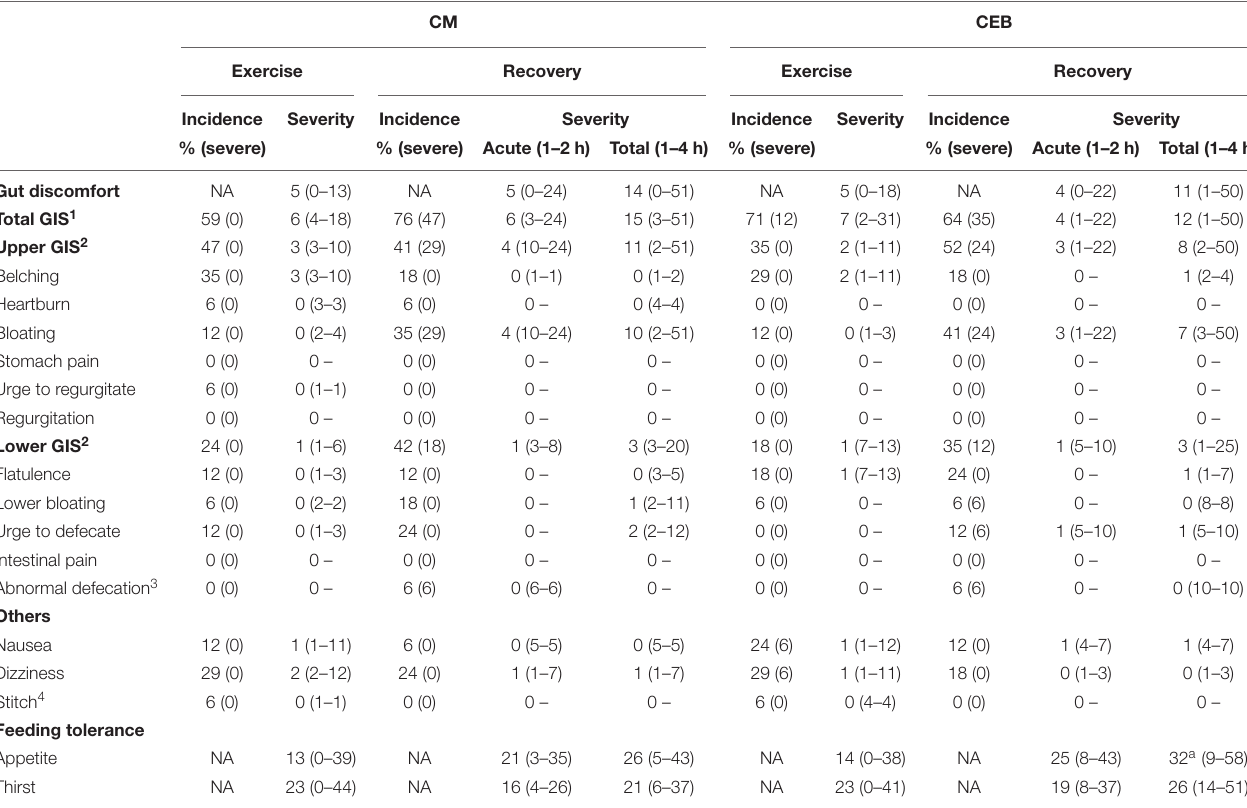
TABLE 2 | Incidence of gastrointestinal symptoms and severity of gut discomfort, total, upper-, and lower-gastrointestinal symptoms in response to 2 h HIIT exercise (between 60 and 80% ˙V O 2max ) in temperate ambient conditions and after consumption of dairy milk (CM) and the carbohydrate-electrolyte (CEB) recovery beverages. CM CEB Exercise Recovery